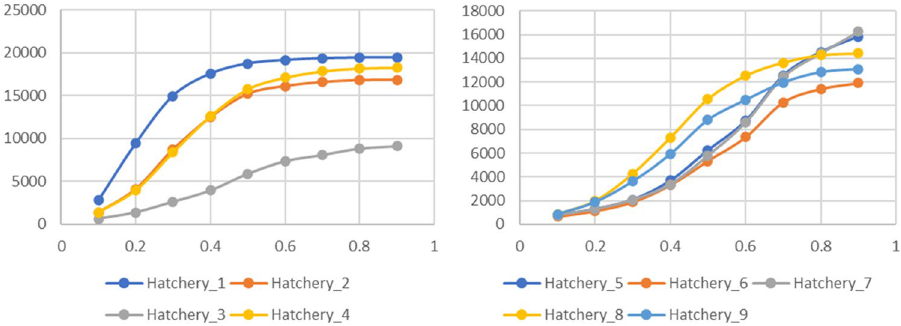
Figure 3. Linkage disequilibrium (LD) by SNP pruning between markers among all the sampled pacu and tambaqui populations (Hatchery 1–9). 21,963 validated SNPs (74.17%) in pacu and 21,072 validated SNPs (71.25%) in tambaqui were